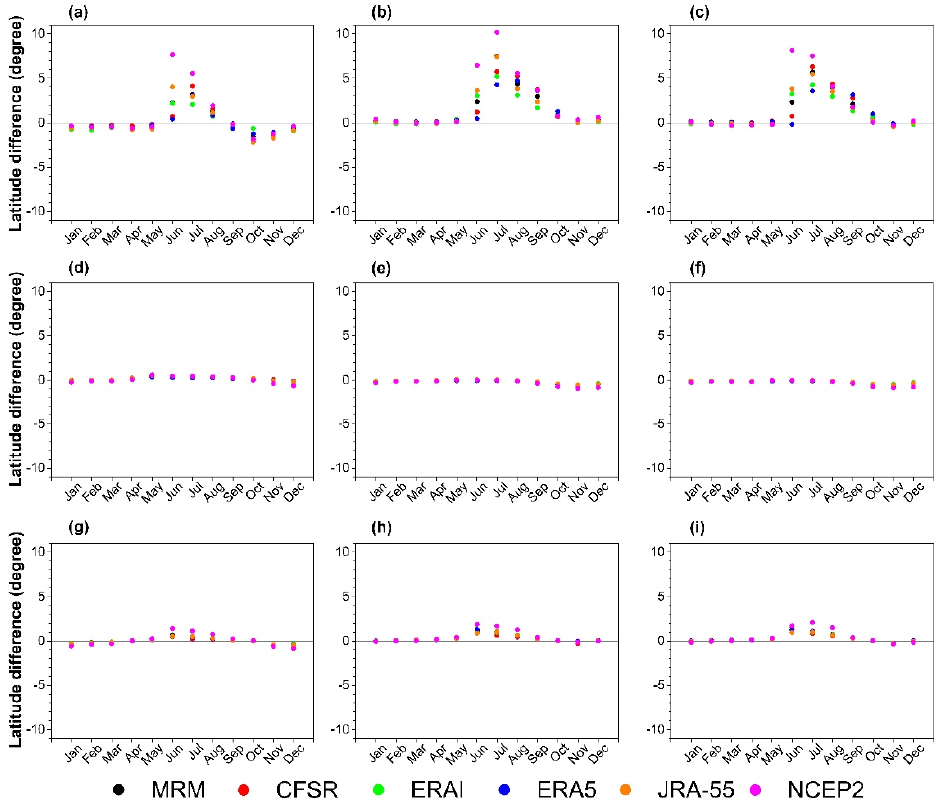
Figure 8. ( a – c ) Annual cycle of the difference between the uncorrected and corrected NE derived from ( a ) M1, ( b ) M2, and ( c ) M3 using the MRM (black), CFSR (red), ERA-Interim (green), ERA5 (blue), JRA-55 (orange), and NCEP2 (magenta) data sets from 1979–2018. ( d – f ) and ( g – l ) are the same as ( a – c ) but for the SE and CE, respectively. The units for the NE, CE, and SE difference are degrees.